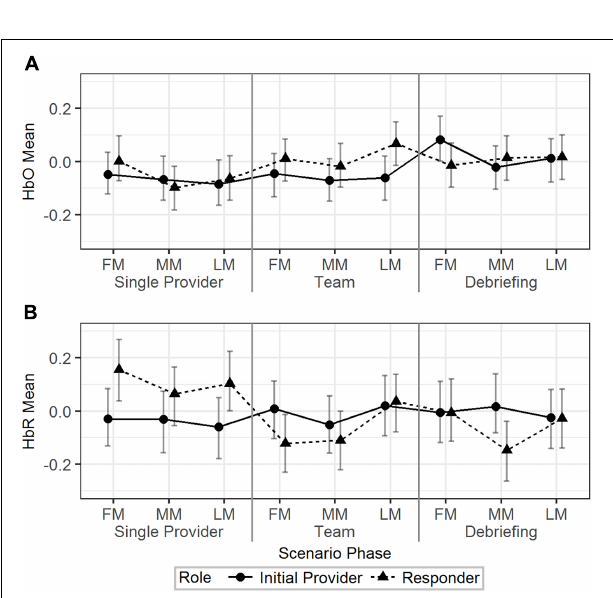
FIGURE 4 | The predicted means and 95% HDIs of the initial provider and the responder’s HbO (A) and HbR (B) levels at the first/middle/last minutes (FM, MM, and LM) of the different scenario phases. The values of all the other variables were held at their